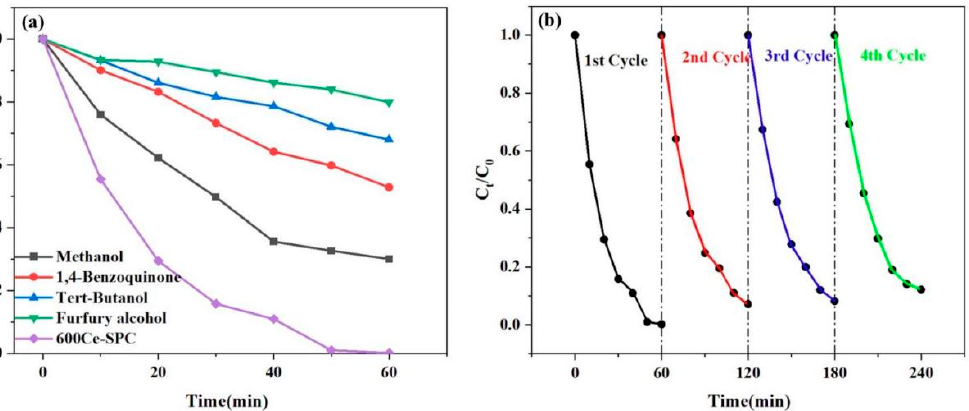
Figure 8. ( a ) The degradation of TC in the active species exploration of methanol with 600 Ce-SPC. ( b ) The reusability of the 600 Ce-SPC samples across four cycles for degradation TC.